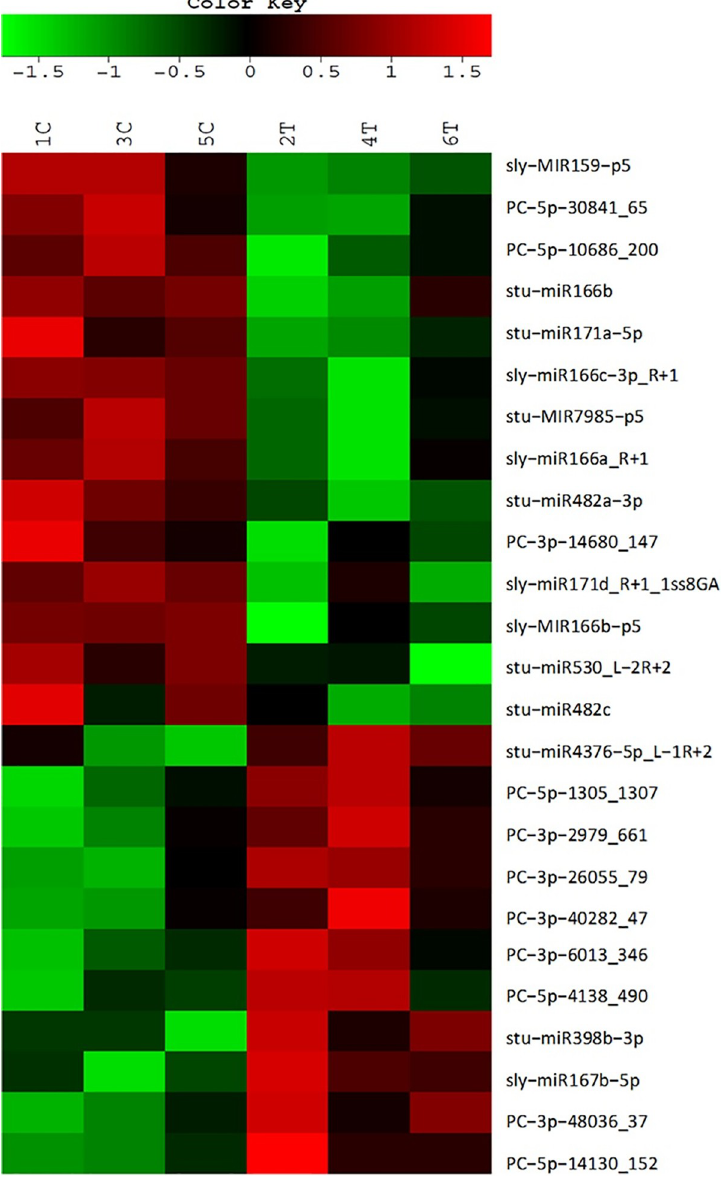
Fig 3. Heat map of differentially expressed miRNAs. KPhi treated (T2, T4, T6) and non treated (C1, C3, C5) replicates were analyzed. Differential expression of miRNAs based on normalized deep-sequencing counts, was analyzed using a Student’s t-test. Up-regulated and down-regulated miRNAs are represented in red and green, respectively.